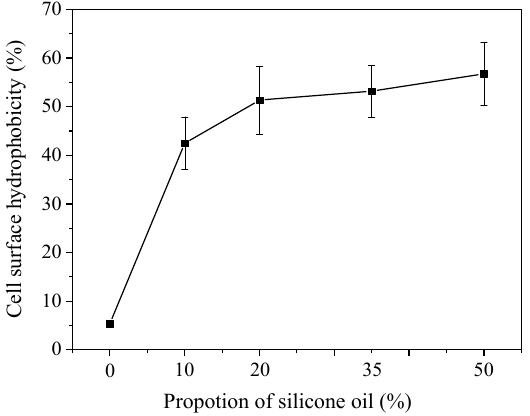
Figure 5. E ff ects of silicone oil on the cell surface hydrophobicity (CSH) of D. tsuruhatensis LW26.